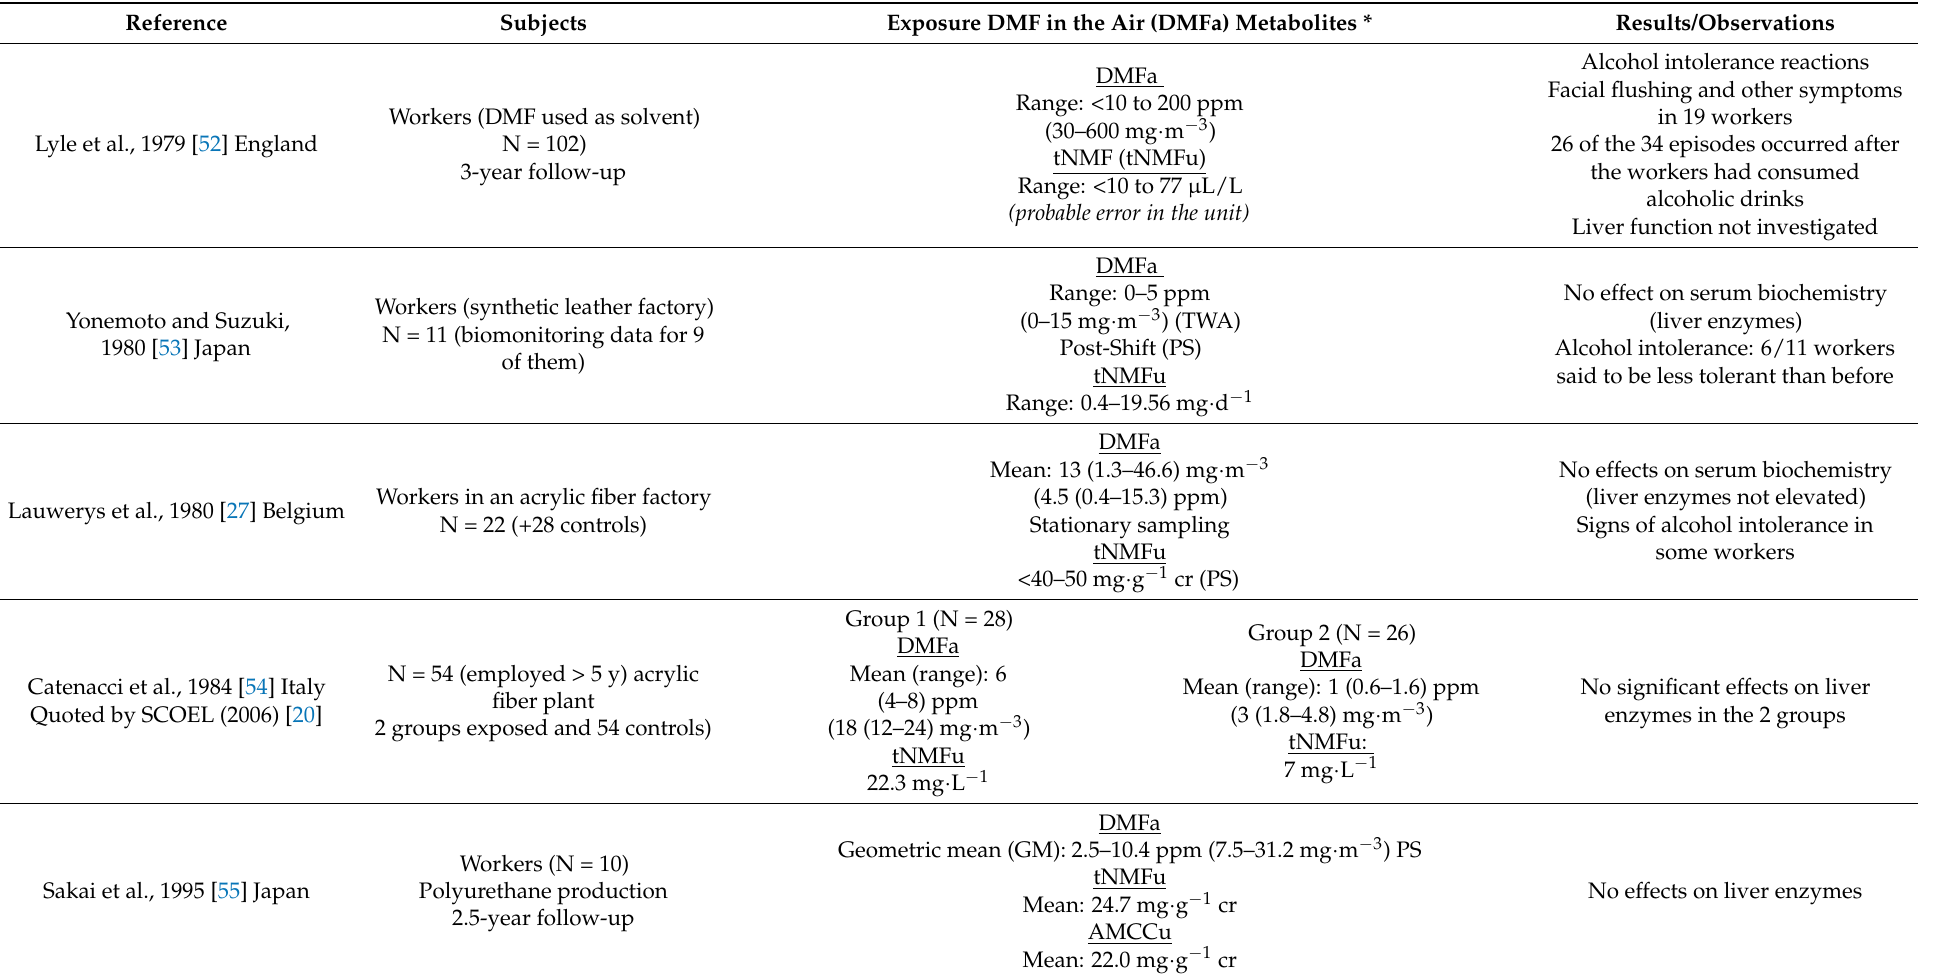
Table 1. Summary of occupational studies reporting health effects of DMF exposure with biomonitoring